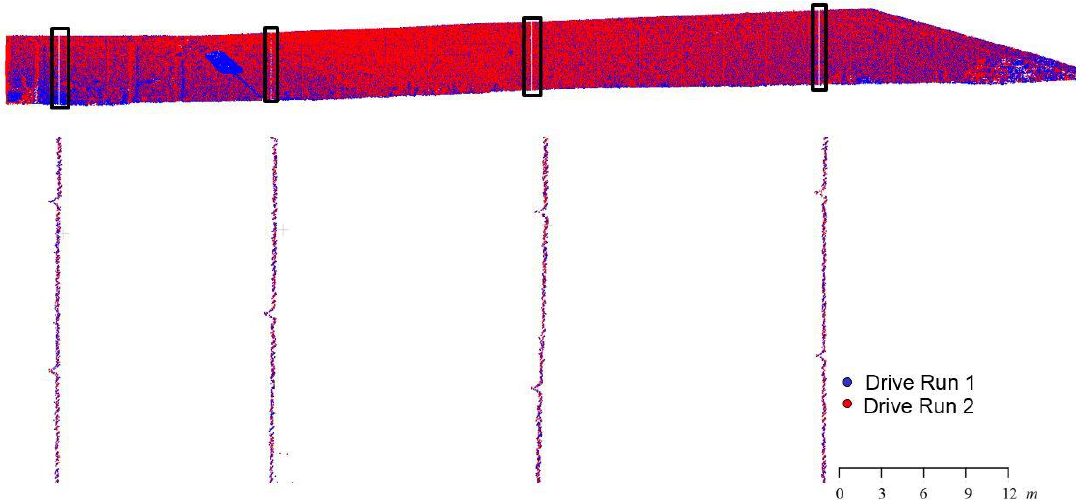
Figure 26. Cross sections illustrating the alignment quality of the Riegl and ZF point clouds from a given drive run of the MSE wall at Site-2.